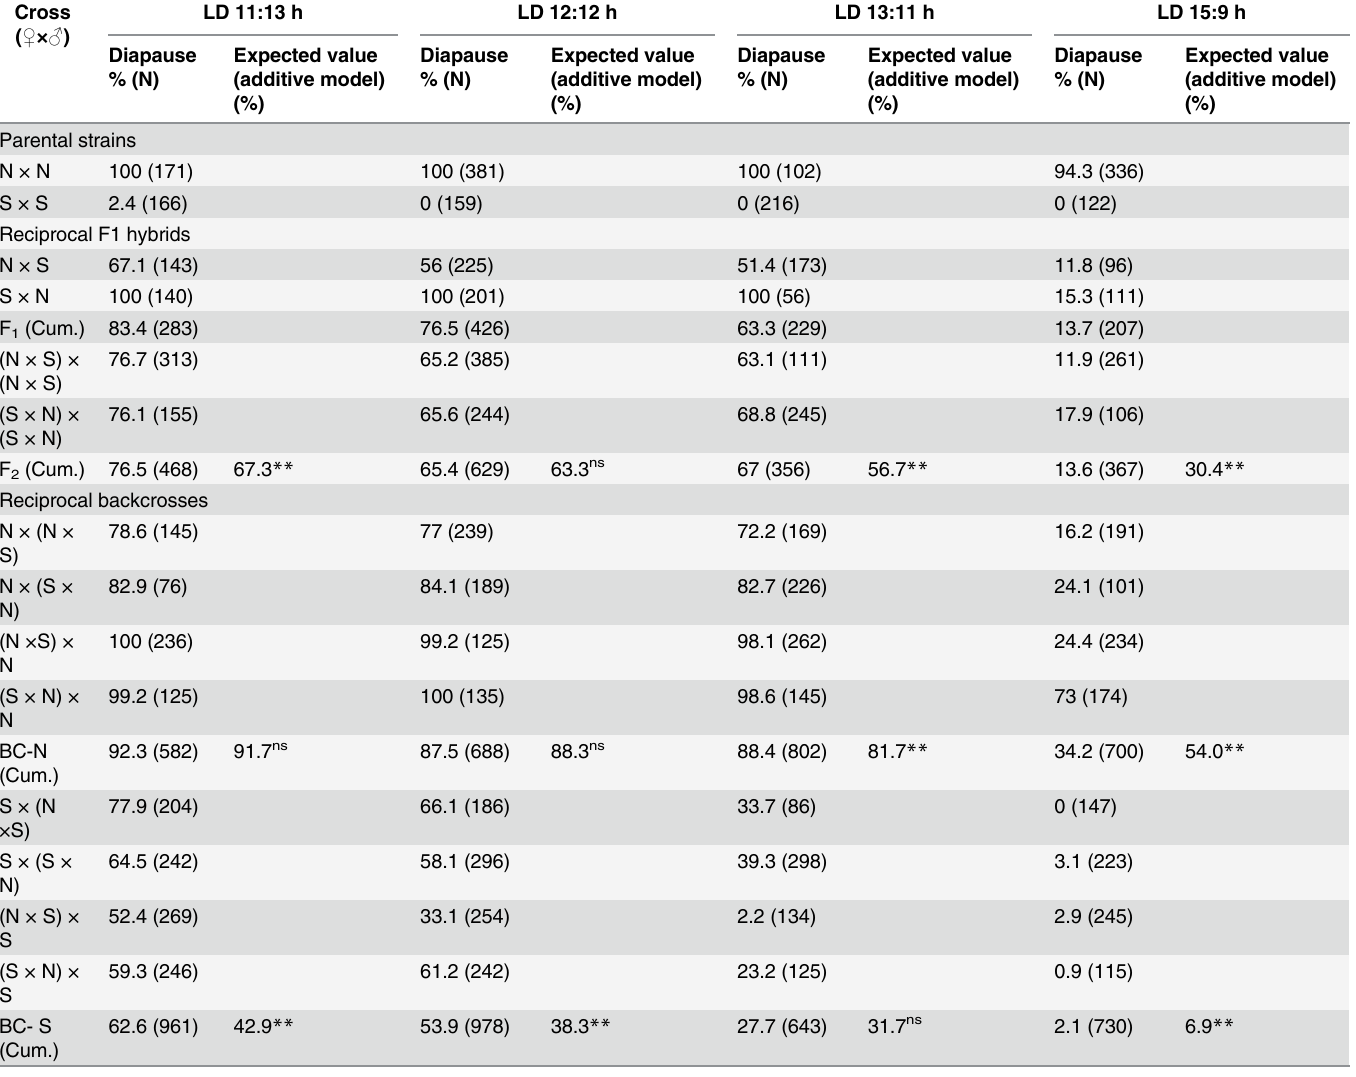
Table 3. Incidence of larval diapause of the parental strain, F 1 , F 2 and backcross progeny in crosses and backcrosses of the N strain and S strain of Ostrinia furnacalis under different photoperiods at